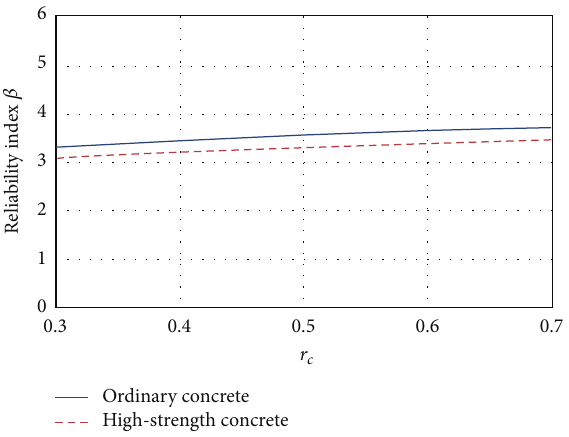
Figure 5: Reliability corresponding to shear failure